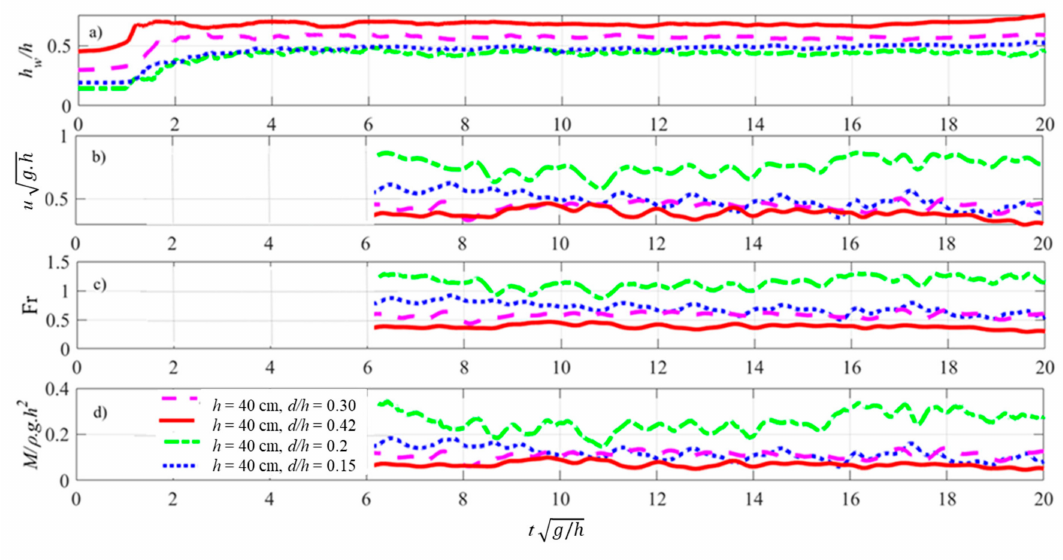
Figure 12. Wet bed bore characteristics at x = 6.5 for h = 40 cm, di ff erent line types show di ff erent d / h values. ( a ) Water surface time-history profile (WG3), ( b ) flow velocity time-history, ( c ) Froude number time-history and ( d ) momentum flux